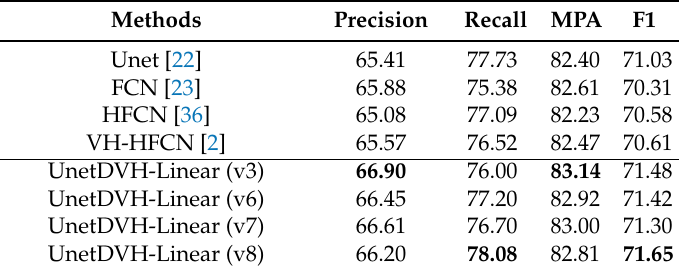
Table 8. Compared with different position of VH-stage for DVH block and v9h9 block on the TuSimple lane test dataset